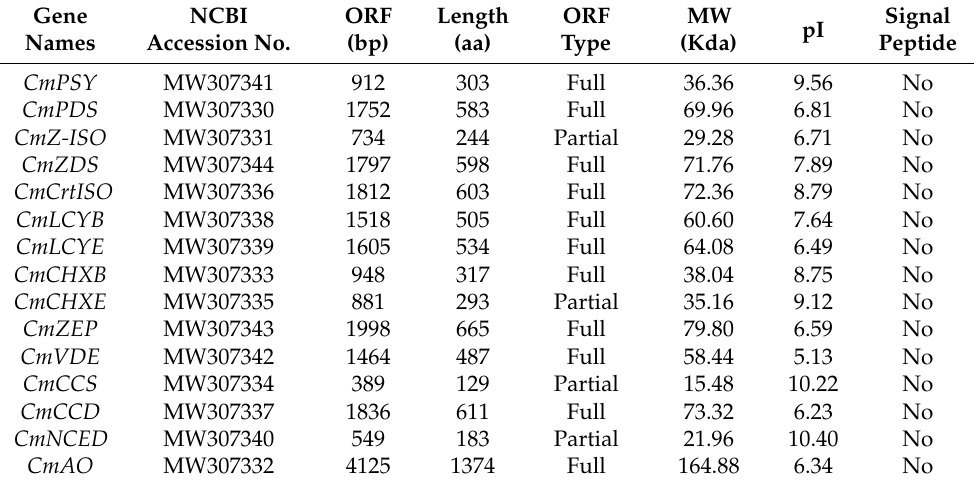
Table 1. Molecular characterization of CBP genes in C. majus.